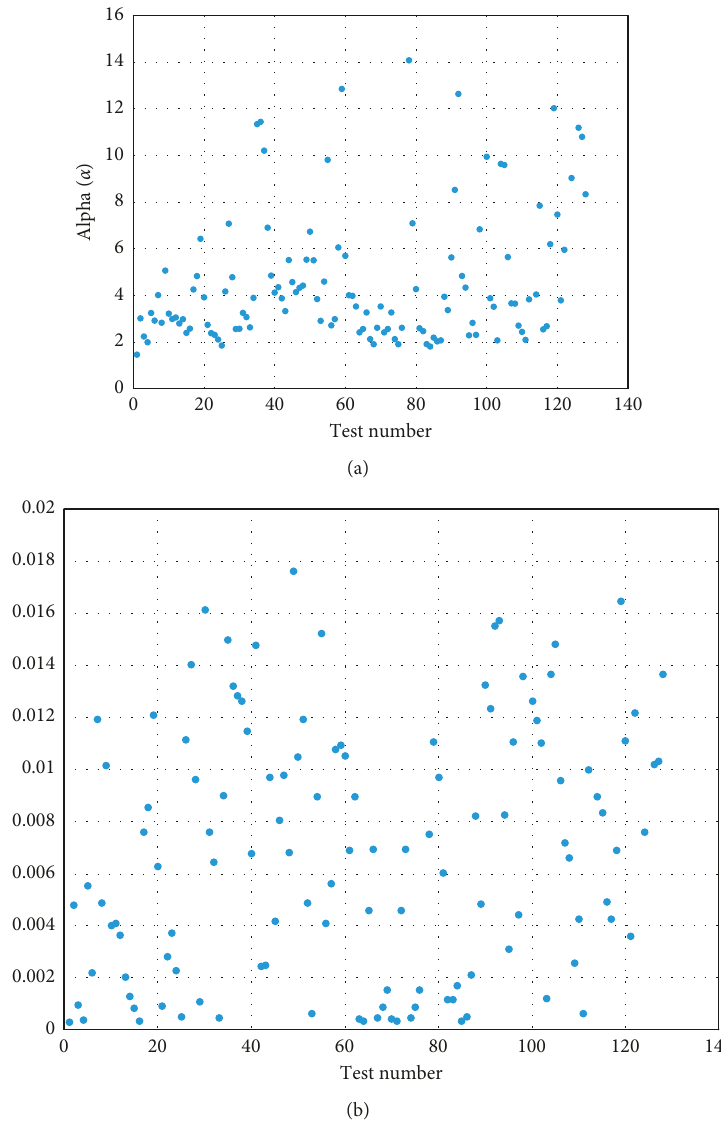
Figure 11: All (a) alpha ( α ) and (b) mse coefficients calculated by using the model proposed by Booker et al.